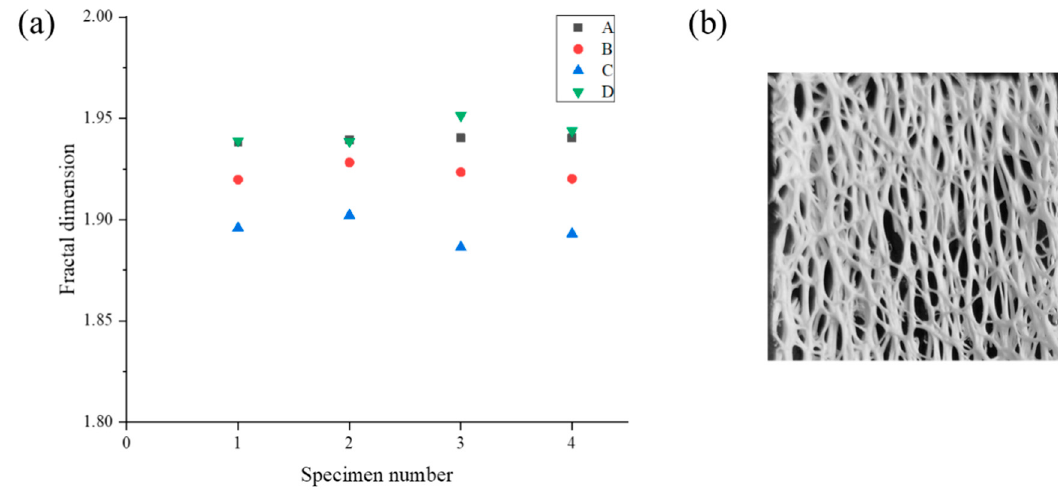
Figure A1. ( a ) The fractal dimension of four kinds of lu ff a sponge; ( b ) specimen from lu ff a sponge’s Figure A1 ( a ) The fractal dimension of four kinds of luffa sponge; ( b ) specimen from luffa sponge’s I I layer.